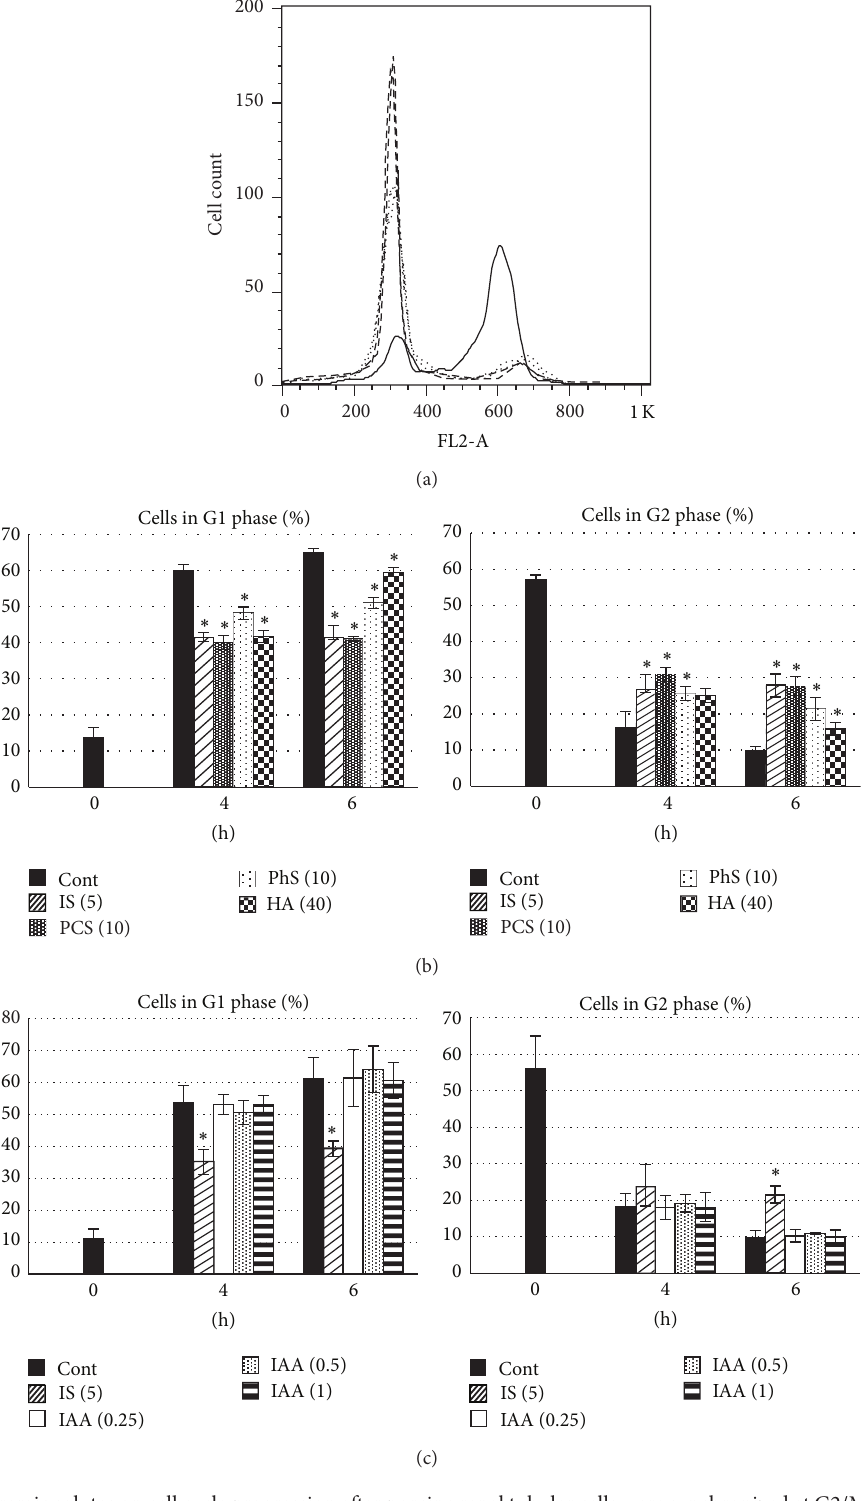
Figure 3: Effects of uremic solutes on cell cycle progression after porcine renal tubular cells were synchronized at G2/M boundary. (a) Time- dependent shift of histograms of untreated control cells. Each line indicates time after release from synchronization. Solid line: 0 hours, dotted line: 4 hours, and dashed line: 6 hours. Duplicate data for each time point are shown except for 0 hours. (b) and (c) Percent of cells in G1 or G2 phase. After synchronization, cells were released to grow with or without uremic solutes for indicated periods. Percent of cells in each phase was analyzed and calculated. Cont, control; IS, indoxyl sulfate; PCS, p -cresyl sulfate; PhS, phenyl sulfate; HA, hippuric acid; IAA, indoleacetic acid. Data are shown as mean ± S.D. ( 𝑛 = 4 ). Asterisks indicate significant difference compared to corresponding control ( 𝑃 < 0.01 ). Concentrations of solutes (mmol/L) are shown in